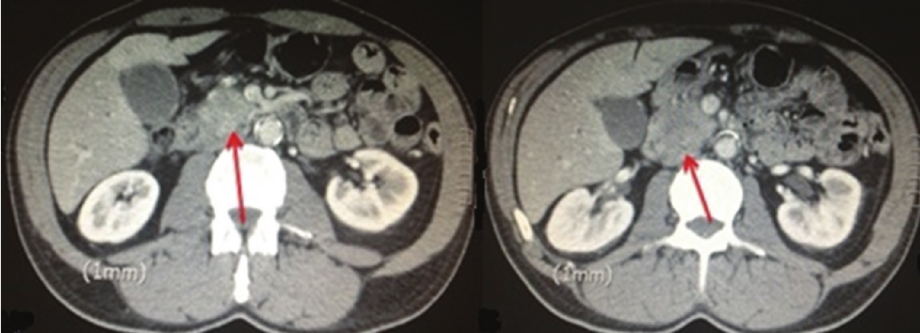
Figure 2: CT abdomen revealing a bulky pancreatic head.